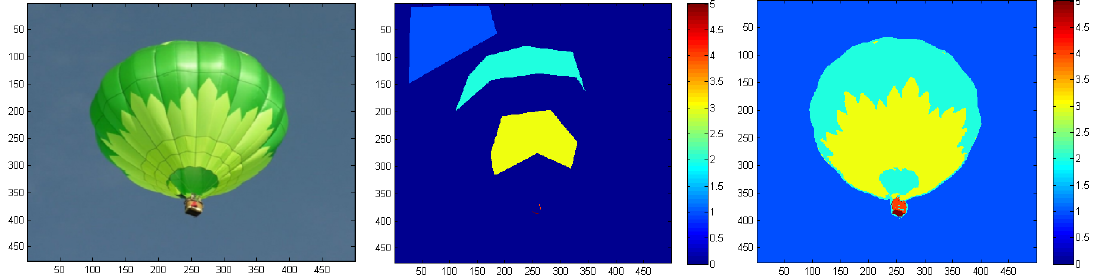
Figure 6. On the left is the original RGB image. In the middle is the ground-truth obtained using the GUI; class 4 and 5, corresponding to the basket, are hardly visible. On the right is the classification obtained using